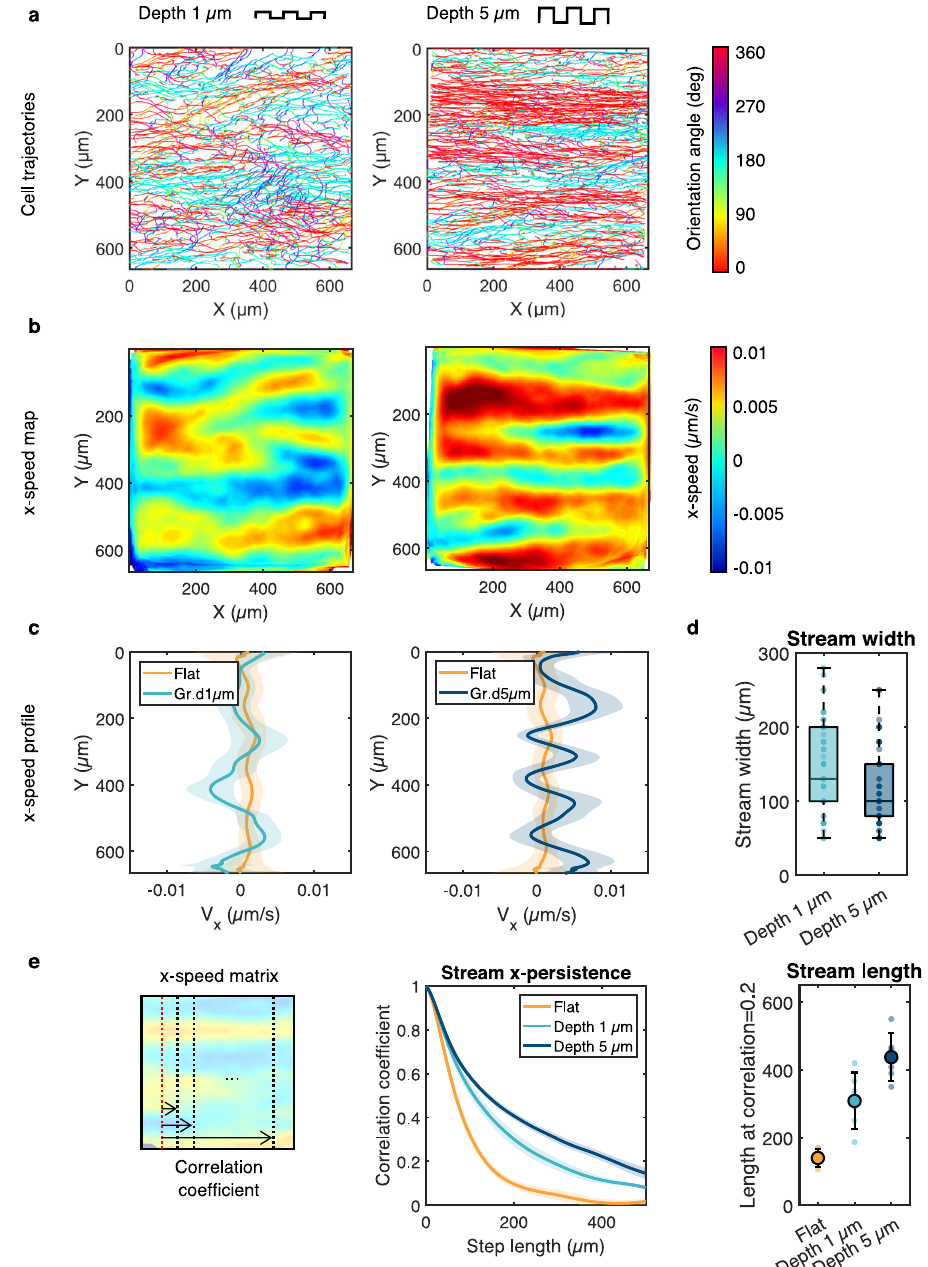
Fig. 2 The spatial features of the streams are modulated by the groove depth. a Cell trajectories after 24h of migration on grooves of width and spacing of 5 µ m and depth of either 1 µ m (left) or 5 µ m (right) color-coded for orientation of displacement vectors. b Heatmaps of the x- speed V x , averaged in time. c Corresponding V x pro fi les along the y-axis averaged over time. Error bars represent standard deviations. d The width of the streams was quanti fi ed as the average width of the peaks (average distance between zero crossings) in the V x pro fi les. Nonparametric t- test (**, p <0.001) n = 61 streams (depth 1 µ m), n = 76 streams (depth 5 µ m) from 6 independent experiments. e Left: the stream persistence along the x-axis was estimated by calculating the Pearson correlation coef fi cient between increasingly distant columns of the V x matrix. Error bars represent SEM. Right: the length of the streams was subsequently estimated as the distance corresponding to a correlation coef fi cient of 0.2 . n = 6 independent experiments, one-way ANOVA, Tukey ’ s post-test (**, p < 0.001). Error bars represent standard deviations. Source data are provided as a Source Data fi between left-right or right-left movement (Supplementary Fig. 4). The cell streams initiated in low-density monolayers and devel- oped over time as the cell density increased and cell junctions matured, with faster establishment of clearly de fi ned and stable streams for high-density monolayers (Supplementary Fig. 4a, b tantly, EDTA treatment disrupted the stream pattern in a dose-